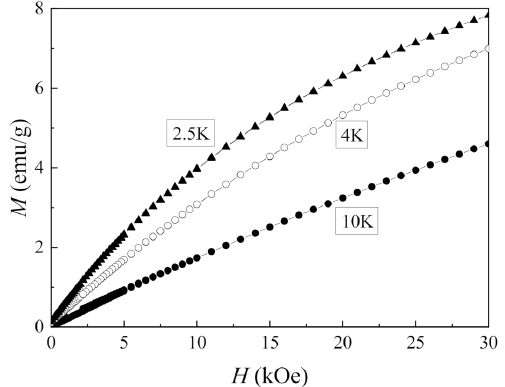
Figure 3. Magnetization curves of the nanocomposite with the ytterbium titanate particles, measured at several